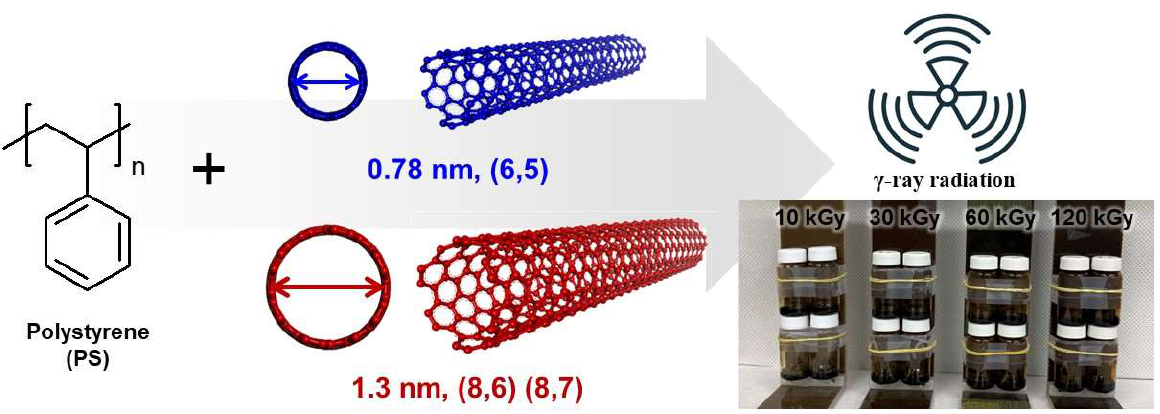
Figure 1. Overview of PS/SW-CNT composites with different diameters of 0.78 and 1.3 nm and various gamma-irradiation conditions.